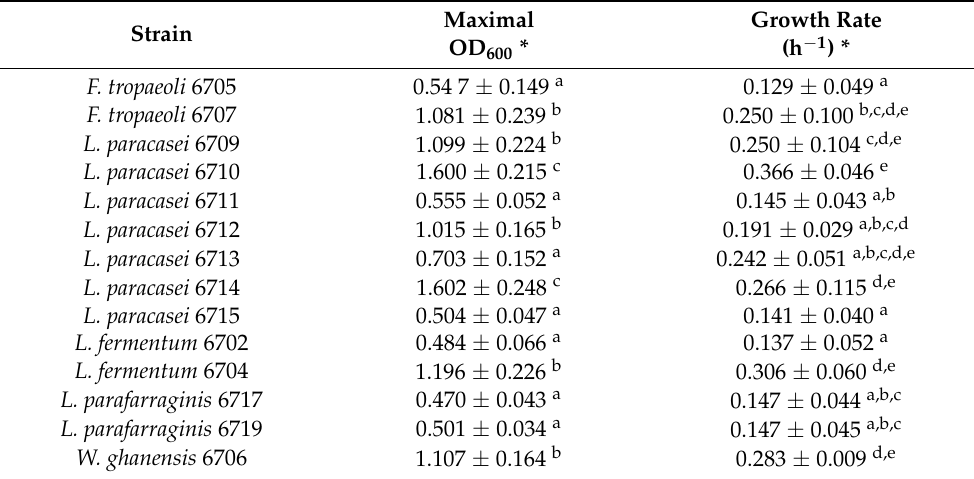
Figure 1. Growth curves of lactic acid bacteria (LAB) isolates obtained from pineapple silage residue in De Man, Rogosa, and Sharpe broth (MRS) media. ( a ) LAB strains different to L. paracasei ; ( b ) LAB belonging to the L. paracasei group. Table 1. Maximal optical density (OD 600 ) and specific growth rates of lactic acid bacteria (LAB) strain growth kinetics in De Man, Rogosa, and Sharpe broth (MRS) media .